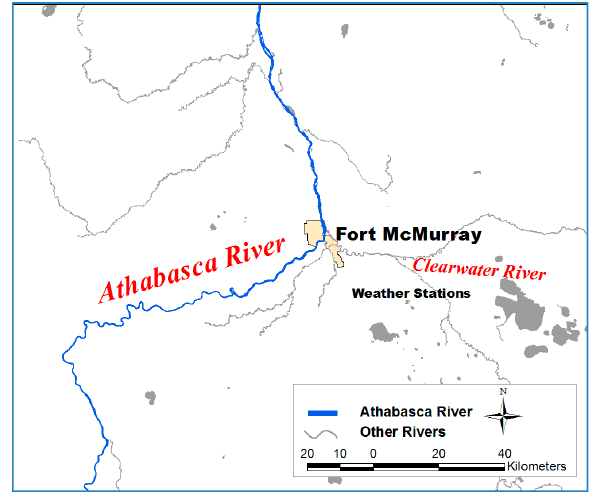
Figure 1. The Athabasca River at Fort McMurray in Alberta, Canada.